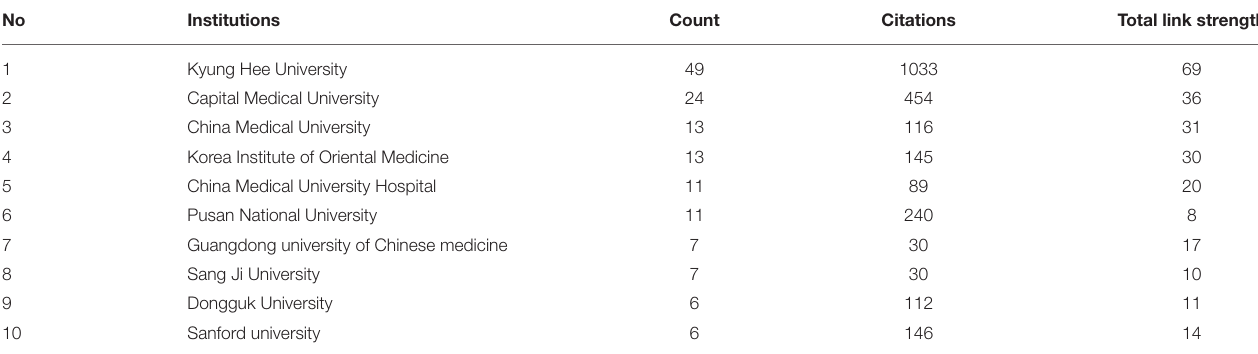
TABLE 2 | Top 10 institutions for publications on acupuncture for PD.